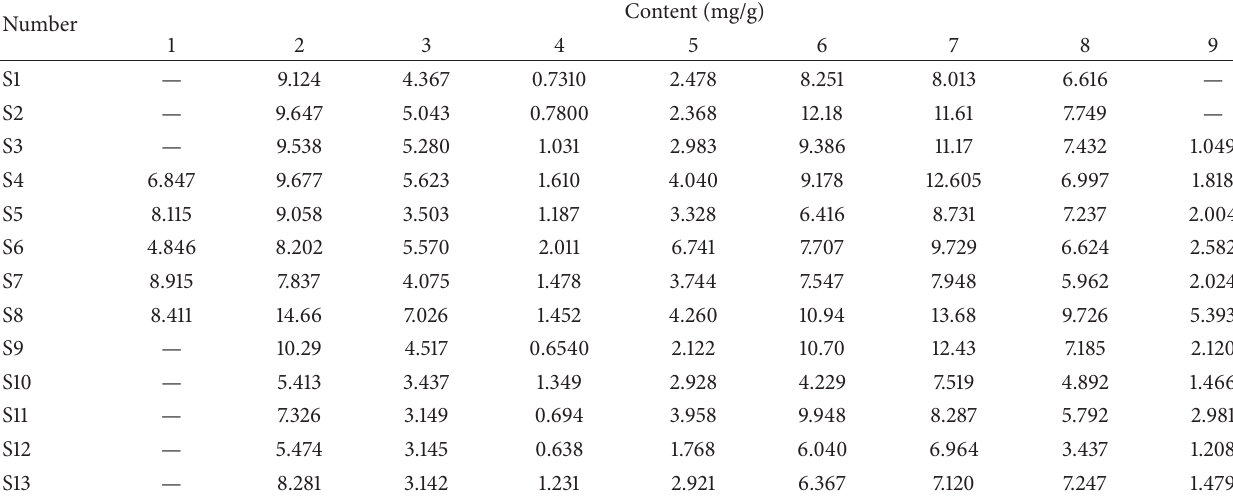
Table 6: Results of absolute quantitative determination of marker compounds.